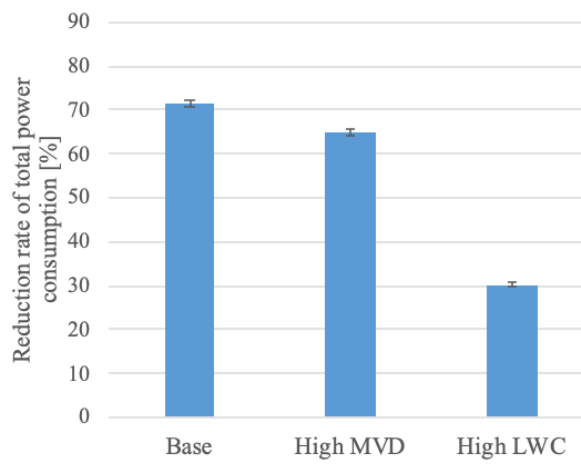
Figure 14. The reduction in the power consumption calculated by Equation (2) by the ICE-WIPS for the demonstration tests.